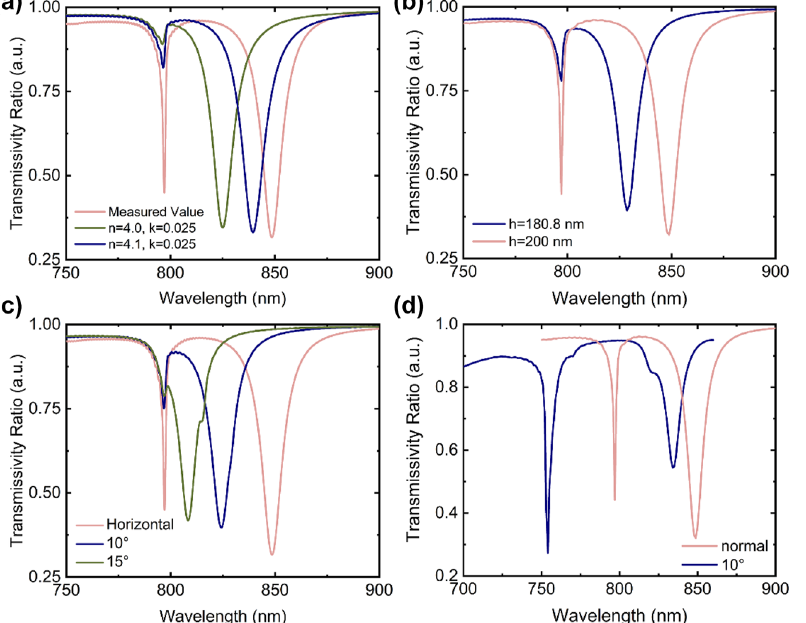
Figure 6: Analysis of the factors influencing the experimental and theoretical deviations. (a) Influence of material properties on the transmission spectra. (b) Transmission spectra of the metasurface with nanopillars of 180.8 nm and 200 nm height, respectively. (c) Transmission spectra with a horizontal nanopillar upper-surface and with inclined upper-surfaces of 10 ◦ and 15 ◦ , respectively. (d) Transmission spectra at normal incidence and at incidence with a pitch angle and an azimuth angle of 10 ◦ , respectively. All the metasurfaces calculated contain eight nanopillars in one